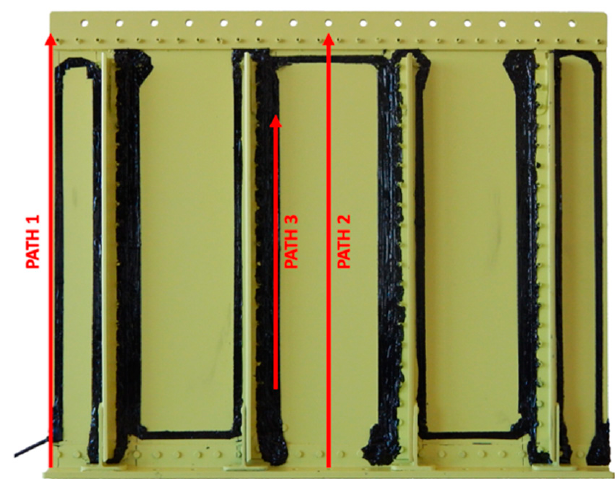
Figure 14. Extraction paths for results comparison.